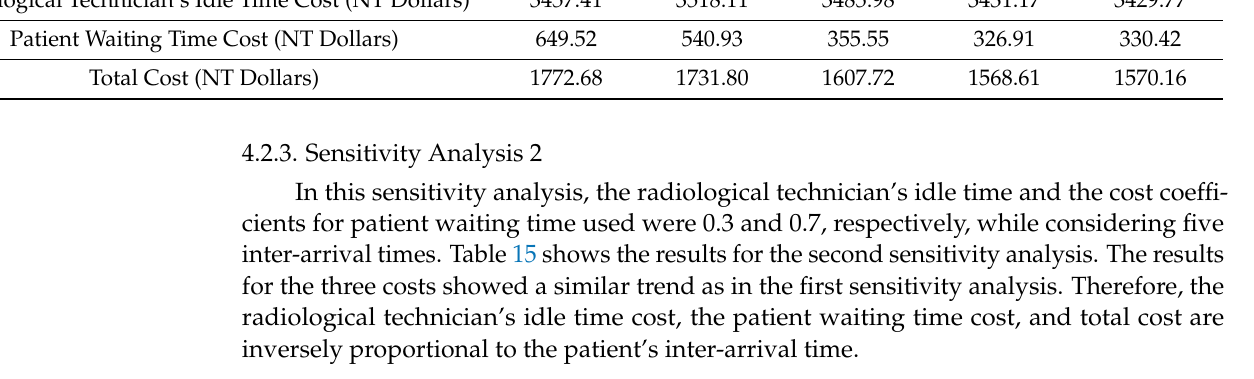
Table 15. Sensitivity analysis 2 with the pair cost coefficients (0.3, 0.7).